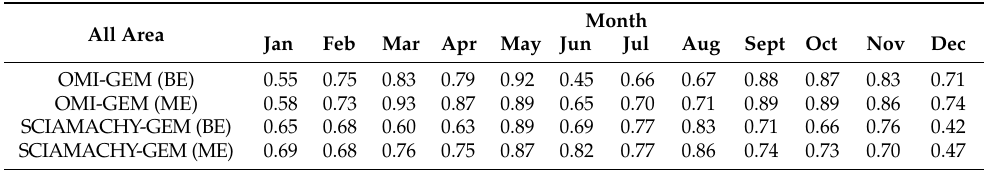
Table 7. Correlation coefficients between NO 2 tropospheric column from satellite data and GEM- AQ base emission (BE) and modified emission (ME) scenarios for 2011 for the Benelux part of the modelling domain.